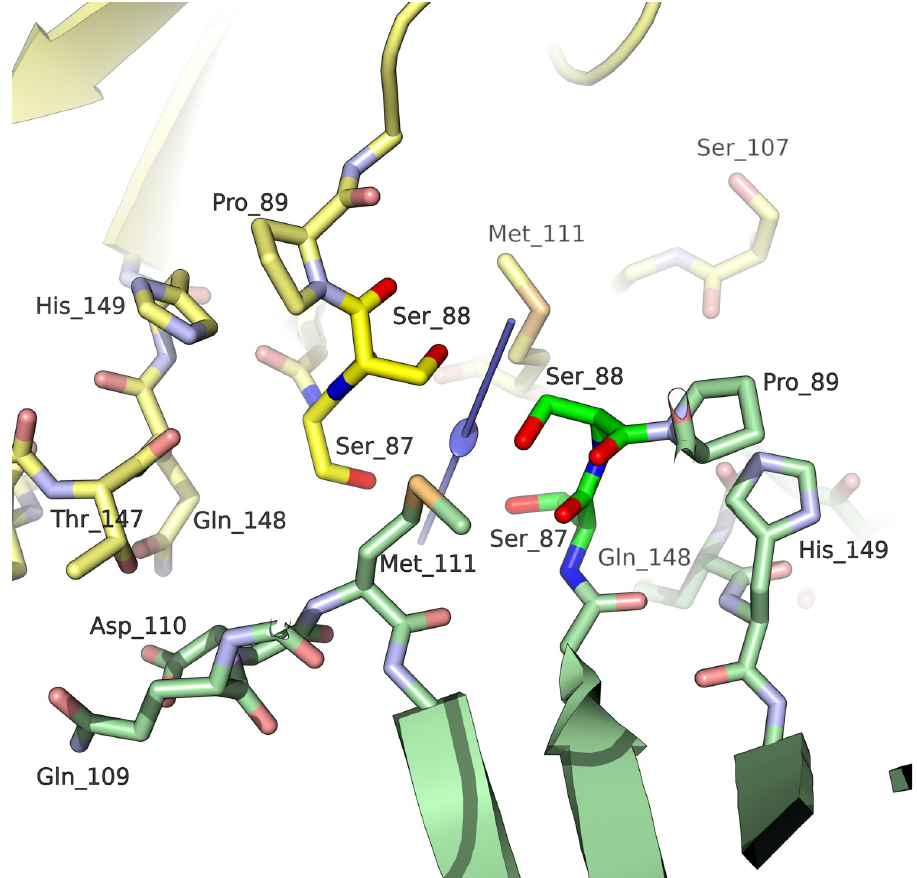
Fig 4. Close-up view of the twofold interface between CPs including Ser 87 and Ser 88. The twofold symmetry axis is shown in light blue colour at the centre of the picture.